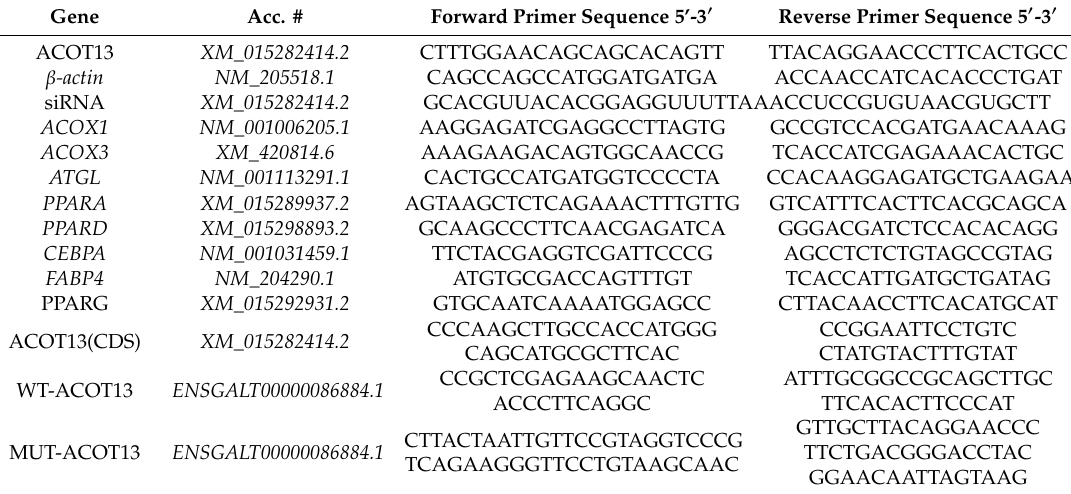
Table 1. Primer sequences used for qPCR in this